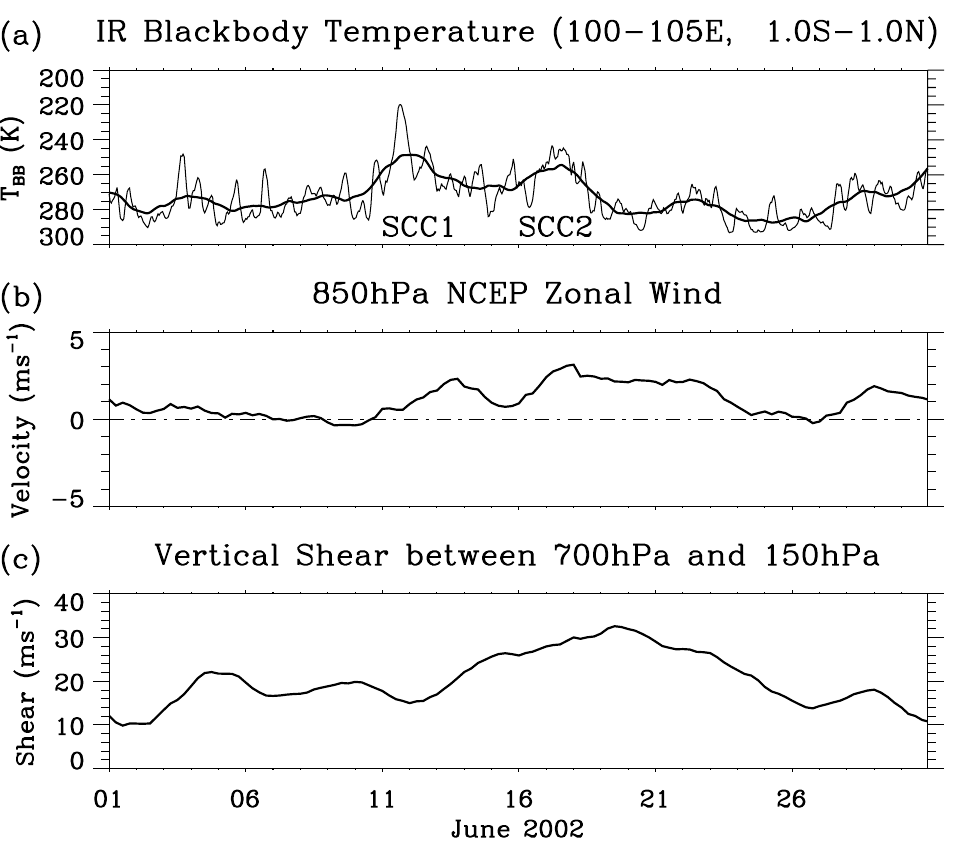
Fig. 5. Time variations of (a) T BB , (b) zonal wind at 850hPa, and (c) vertical shear of horizontal wind between 700hPa and 150hPa. Wind data are derived from NCEP/NCAR reanalysis. In panel (a) , T BB is averaged over 100 ◦ E–105 ◦ E longitudinally and 1 ◦ S–1 ◦ N latitudinally. Thick solid curve shows T BB smoothed by 2-day running mean, and thin solid curve shows T BB observed every one hour. In panels (b) and (c) , zonal wind at 850hPa and vertical shear of horizontal wind between 700hPa and 150hPa are averaged over 100 ◦ E–105 ◦ E longitudinally and 2.5 ◦ S–2.5 ◦ N latitudinally. Zonal wind at 850hPa and vertical shear of horizontal wind between 700hPa and 150hPa are smoothed by 2-day running